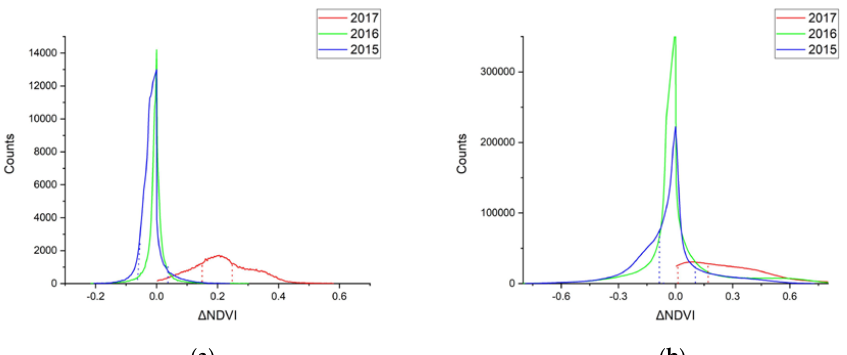
Figure 4. The histogram of ΔNDVI. ( a ) Dominica ( Δ NDVI 2017: pre-hurricane: 09/09/2017, post- hurricane: 09/21/2017, Δ NDVI 2016: pre-hurricane: 09/18/2016, post-hurricane: 10/20/2016, Δ NDVI 2015: pre-hurricane: 09/16/2015, post-hurricane: 10/18/2015); ( b ) Puerto Rico ( Δ NDVI 2017: pre- hurricane: 09/17/2017, post-hurricane: 10/03/2017, Δ NDVI 2016: pre-hurricane: 09/14/2016, post- hurricane: 10/16/2016, Δ NDVI 2015: pre-hurricane: 09/28/2015, post-hurricane: